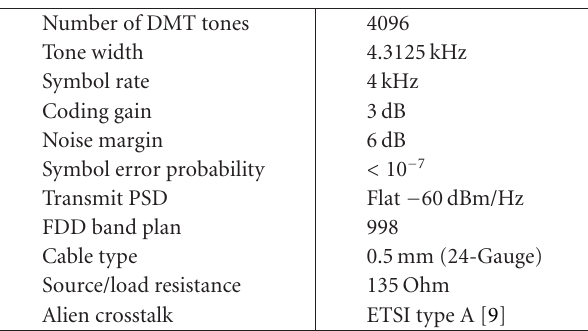
Table 3: Simulation parameters.